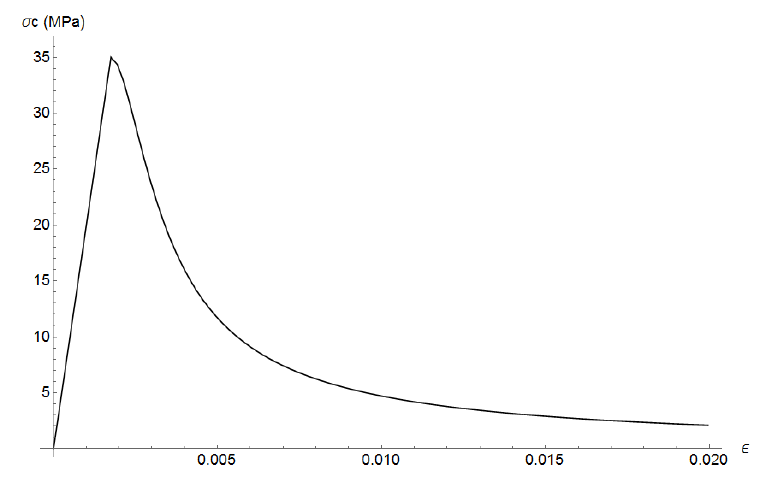
Figure 5. Mortar: uniaxial compressive stress-strain relation.